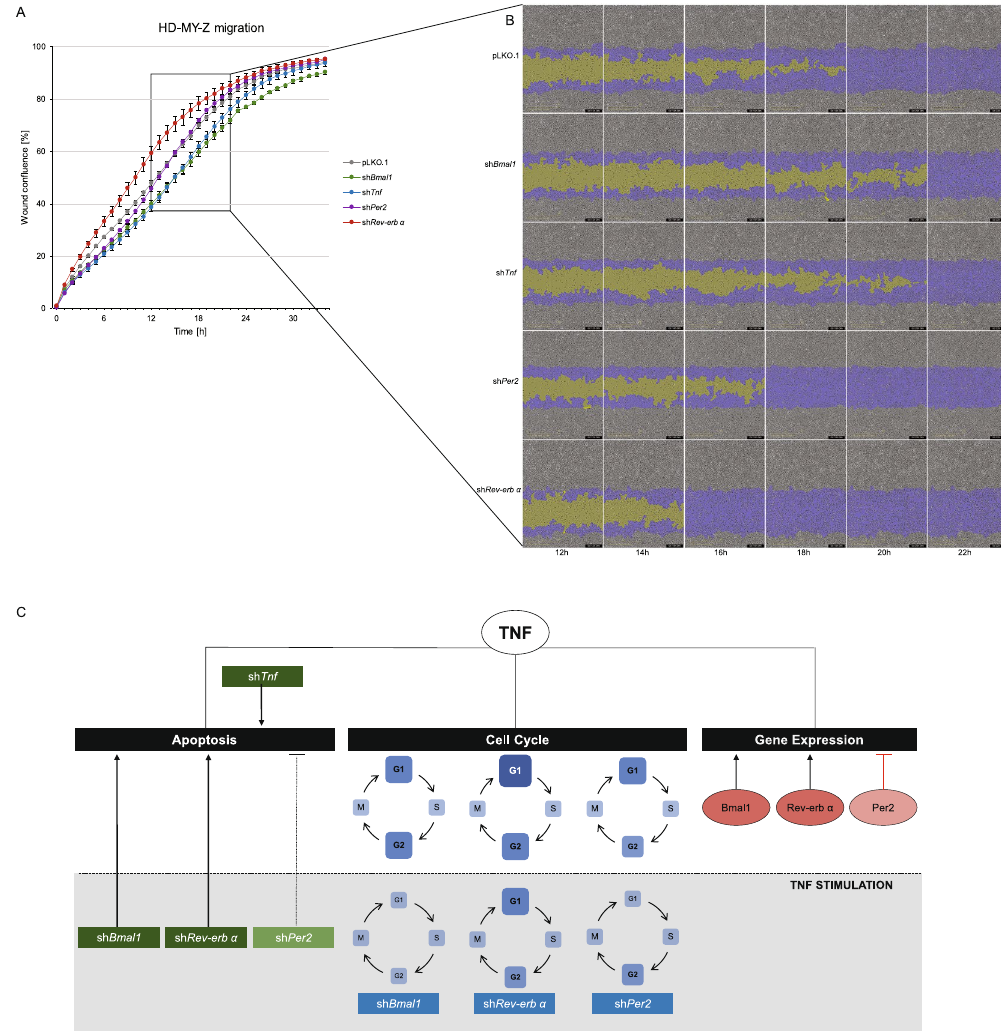
Figure 6. Tnf and core-clock genes affected cell migration in the HL cell line HD-MY-Z. ( A ) Migration properties of pLKO.1 empty vector and KD HD-MY-Z cell lines ( shBmal1, shTNF, shPer2 and shRev-erb α ), measurements were obtained using a scratch wound assay for the IncuCyte S3 Live Cell System Analysis. Quantification was performed by measuring the relative wound confluence over the course of 34 hours. (n = 3, mean ± SEM). ( B ) Partial representation of the scratch wound assay for all HD-MY-Z KD derived cell lines in the course of 12–22 hours. Images were obtained with the IncuCyte S3 Software. Yellow mask indicates the wound border locations. Blue mask indicates the initial scratch wound area. ( C ) A model for the bi-directional role of TNF and the core-clock in regulating the molecular and cellular characteristics in HL. TNF regulates gene expression, cell cycle and apoptosis by interacting with the core-clock elements Bmal1 , Per2 and Rev- erb α (orange circles). The grey area represents stimulatory effects of TNF on KD cell lines. TNF stimulation differentially affects the cell cycle phases of the KD cell lines, as illustrated by the different sizes and colour of each blue square (compared to pLKO.1). Cellular apoptosis is influenced by TNF stimulation in shRNA cell lines leading to its activation (sh Bmal , sh Rev-Erb) or inhibition (sh Per2